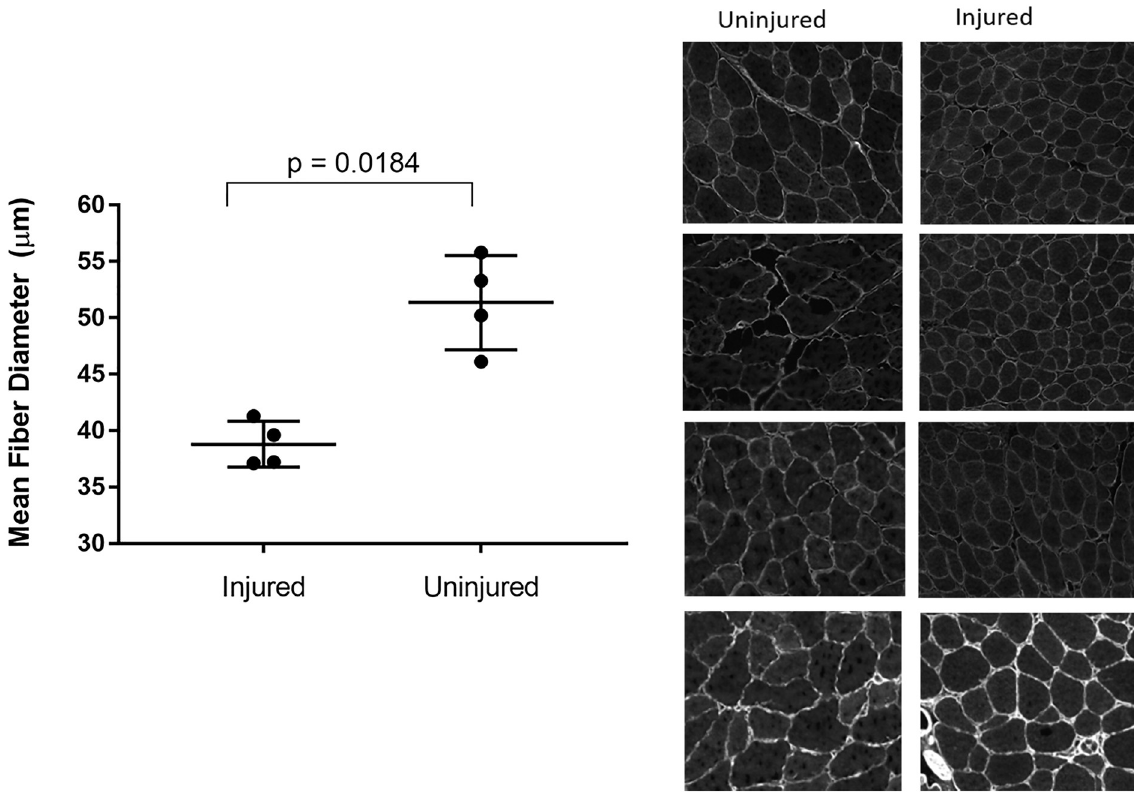
Fig 5. MyoSAT detects difference in muscle fiber diameter following nerve transection. Analysis used to evaluate change in muscle morphology in murine TA muscle 5 weeks after a common peroneal nerve transection. MyoSAT reveals significant differences in average fiber size between transected and uninjured sides. (n = 4 mice) Error bars = Std. Error.